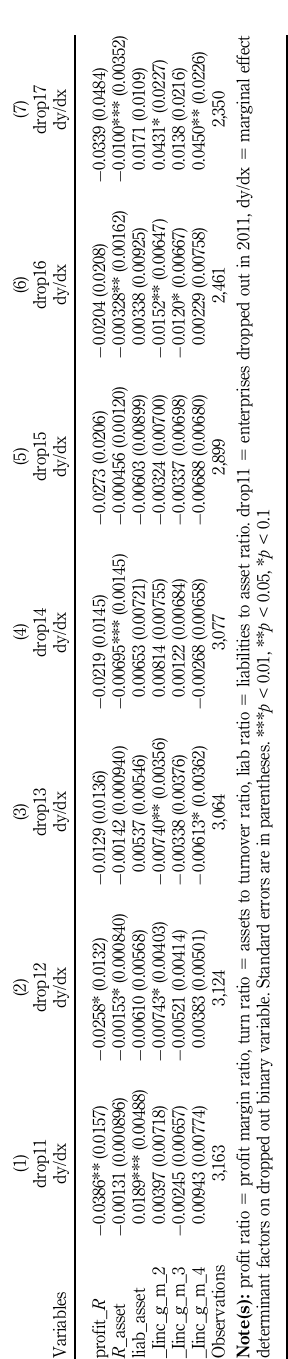
Table 5. Logit regression